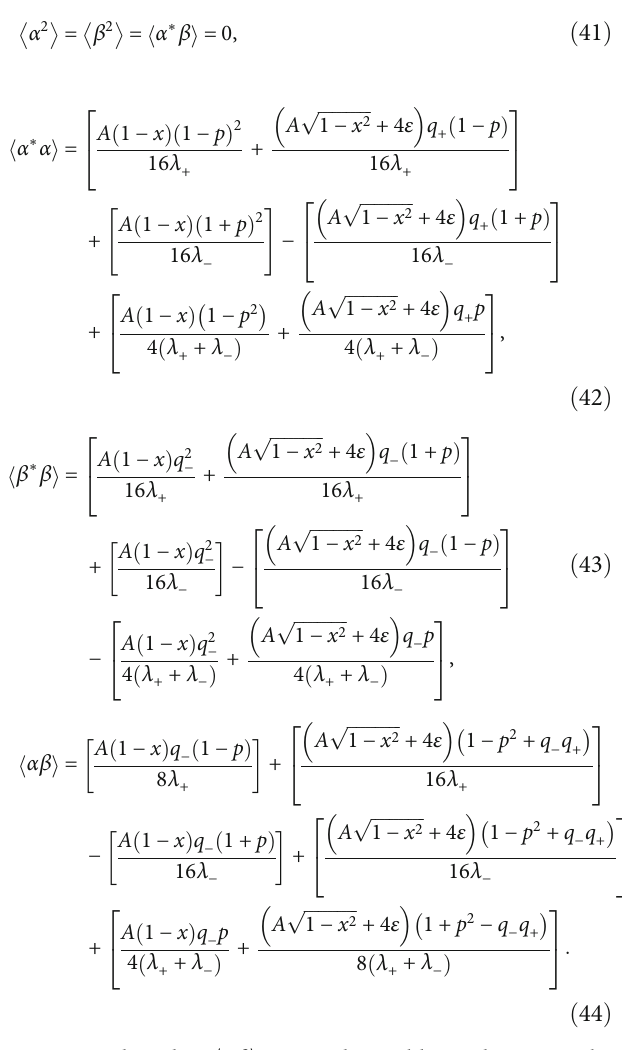
Figure 2: Quadrature variance Δ c 2 and di ff erent values of the linear gain coe ffi cient A